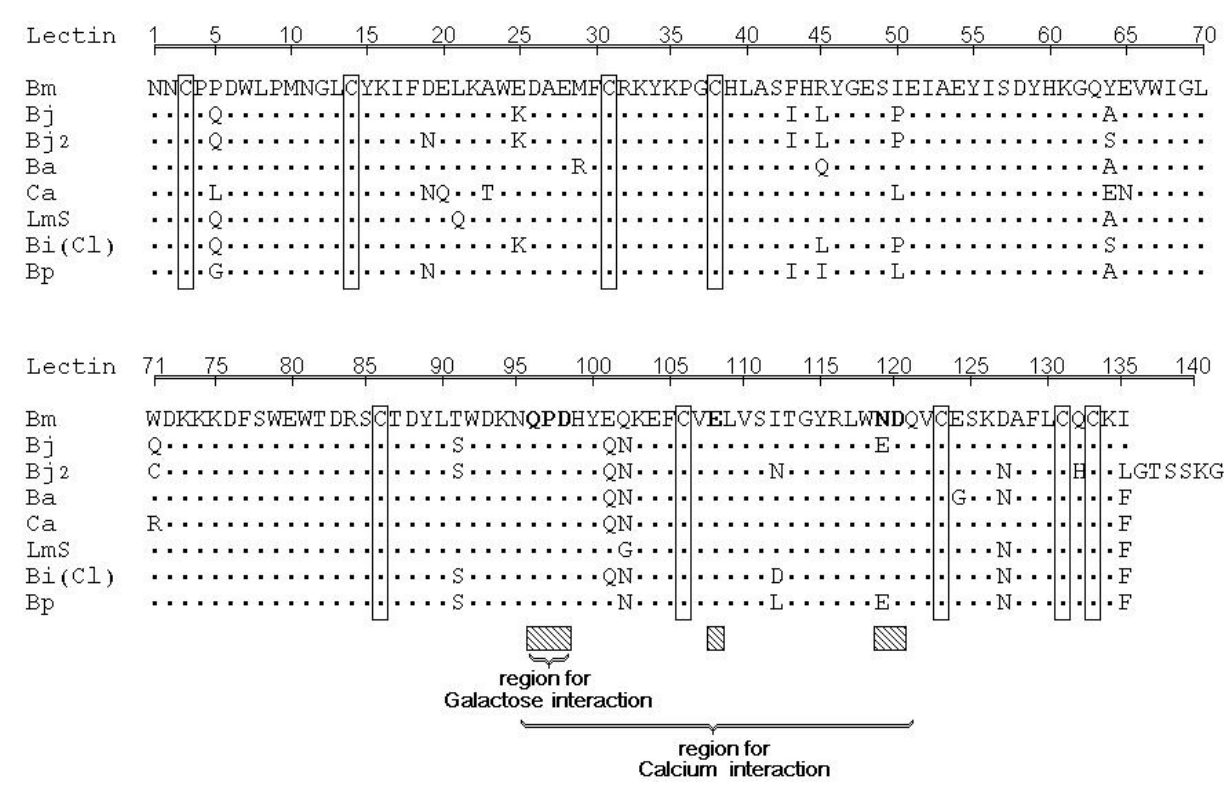
Figure 4. Amino acid sequence of the lectin from Bothrops moojeni (Bm) venom compared with Bothrops jararacussu (Bj), Bothrops jararacussu 2 (Bj2), Bitis arietans (Ba), Crotalus atrox (Ca), Lachesis muta stenophrys (Lms), Bothrops insularis (Bi) and Bothrops pirajai (Bp) lectins obtained from PubMed and Swiss Plot protein data banks.